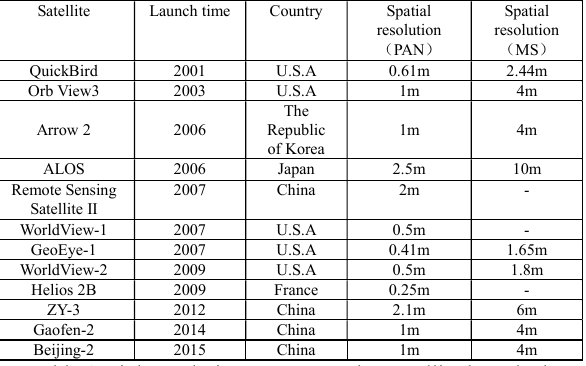
Table 1.High resolution remote sensing satellite launched